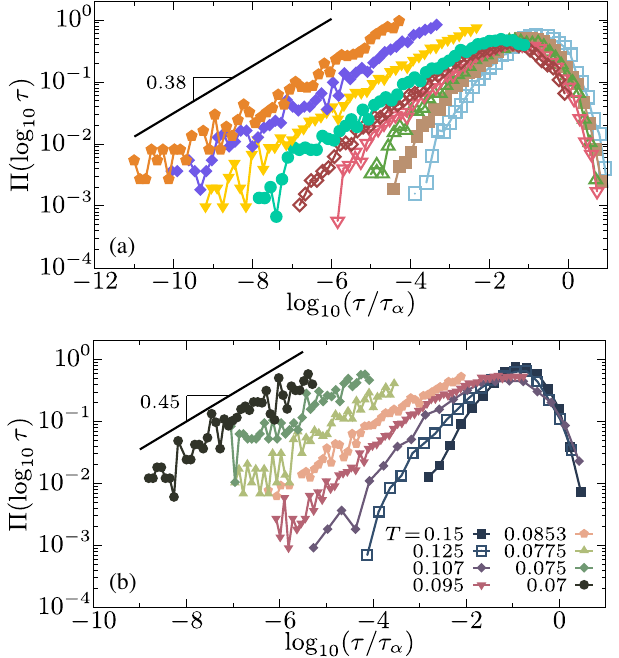
FIG. 10. Emergence of a power-law tail in the waiting- time distribution of relaxed clusters. Waiting-time distribution Π ð log τ Þ for the appearance of new clusters of relaxed particles in (a) 3D and (b) 2D. Close to T , the distribution is well fitted at g short times τ = τ α ≪ 1 by a power law with an exponent b ≈ 0 . 38 (in 3D) and 0.45 (in 2D). Legend as in Fig.